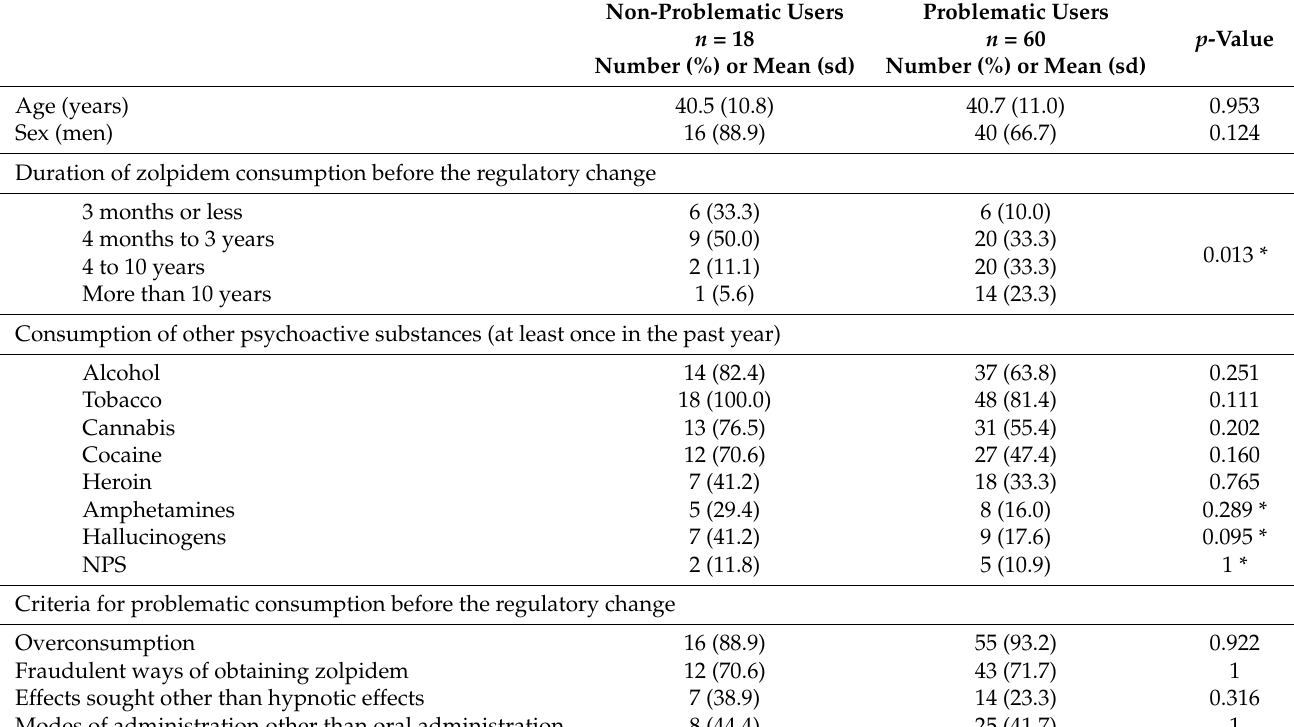
Table 5. Comparison of problematic and nonproblematic users after the regulatory change among SCDD users who had problematic consumption of zolpidem before the regulatory change ( n =